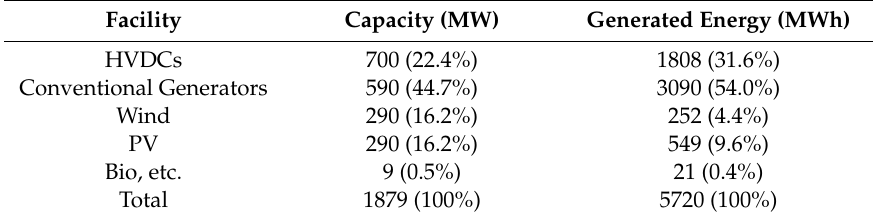
Figure 1. Configuration of the Jeju power system. Table 1. Jeju power facilities and renewable energy